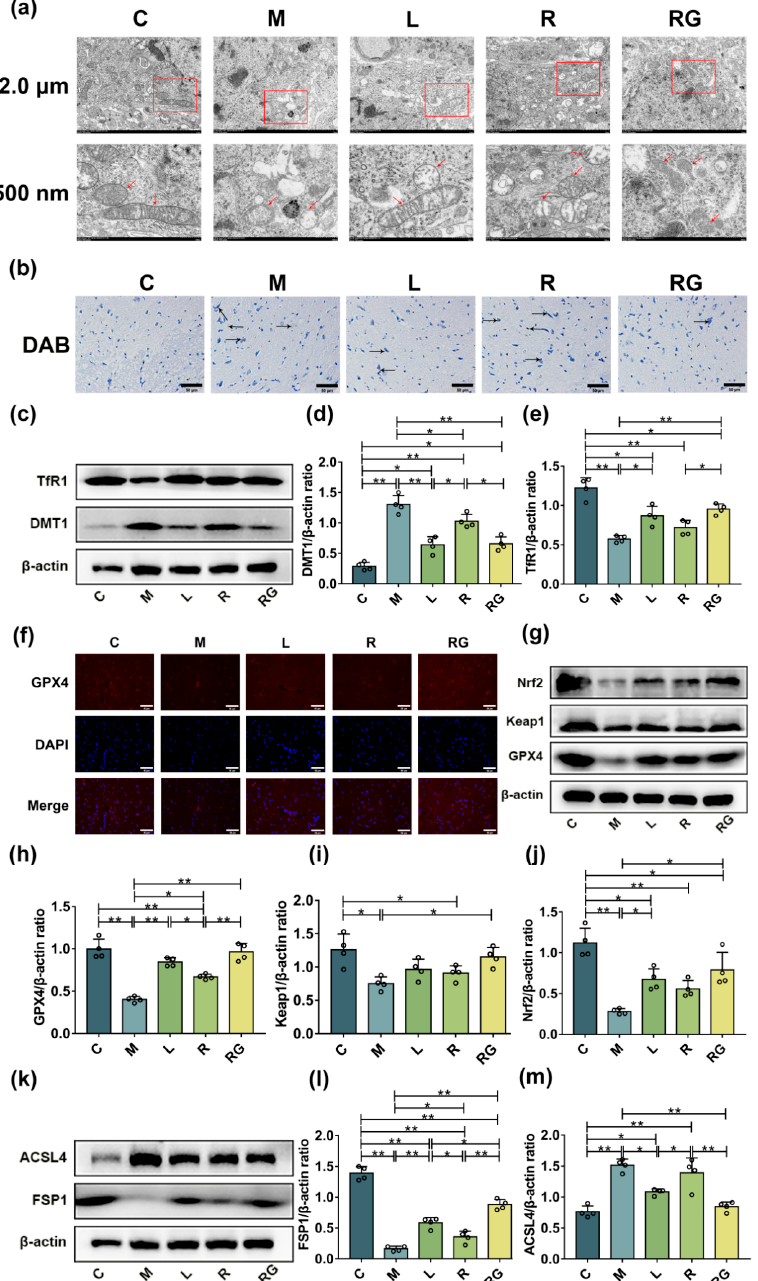
Figure 4. L. lactis MG1363-pMG36e-GLP-1 inhibited ferroptosis via potentiating the Keap1-Nrf2- GPX4 pathway in PD model mice. ( a ) Ultrastructure of mitochondria in SN of PD model mice as measured by TEM; the red box and arrow indicated mitochondria (scale bar = 2.0 µ m or 500 nm). ( b ) Perls’ staining image of SN in PD model mice; the black arrow indicated iron deposition (scale bar = 50 µ m). ( c ) Western blotting of TfR1, DMT1, and β -actin in SN. ( d , e ) Relative quantification of TfR1 and DMT1 protein levels adjusted to internal reference β -actin ( n = 4). ( f ) Representative photomicrographs of GPX4 in the SN of PD mice as measured by IF staining (scale bar = 50 µ m). ( g ) Representatives Western blotting of GPX4, Keap1, Nrf2, and β -actin in the SN. ( h – j ) Quantification of GPX4, Keap1, and Nrf2 protein levels adjusted to β -actin ( n = 4). ( k ) Representative Western blotting of FSP1, ACSL4, and β -actin in the SN. ( l , m ) Relative quantification of FSP1 and ACSL4 protein levels adjusted to β -actin ( n = 4). * p < 0.05 and ** p <